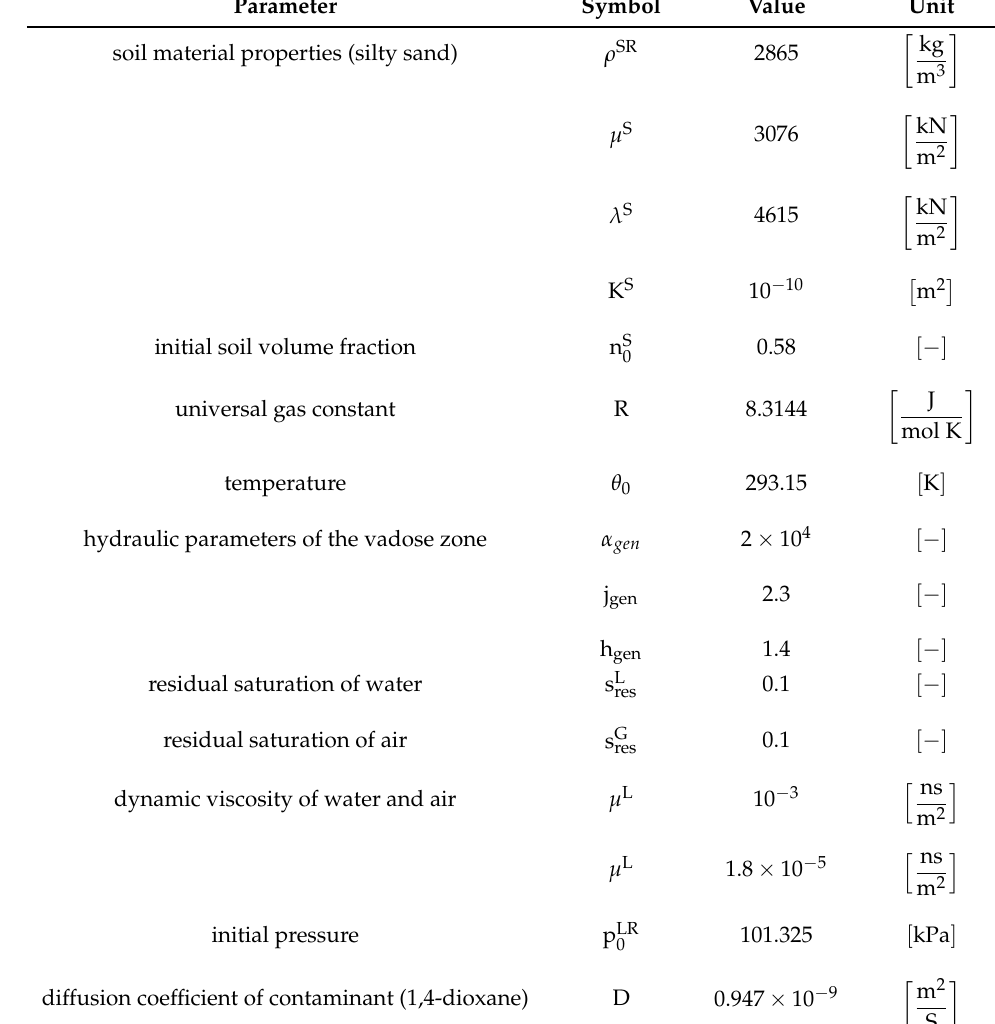
Table 1. Material parameters and initial values.